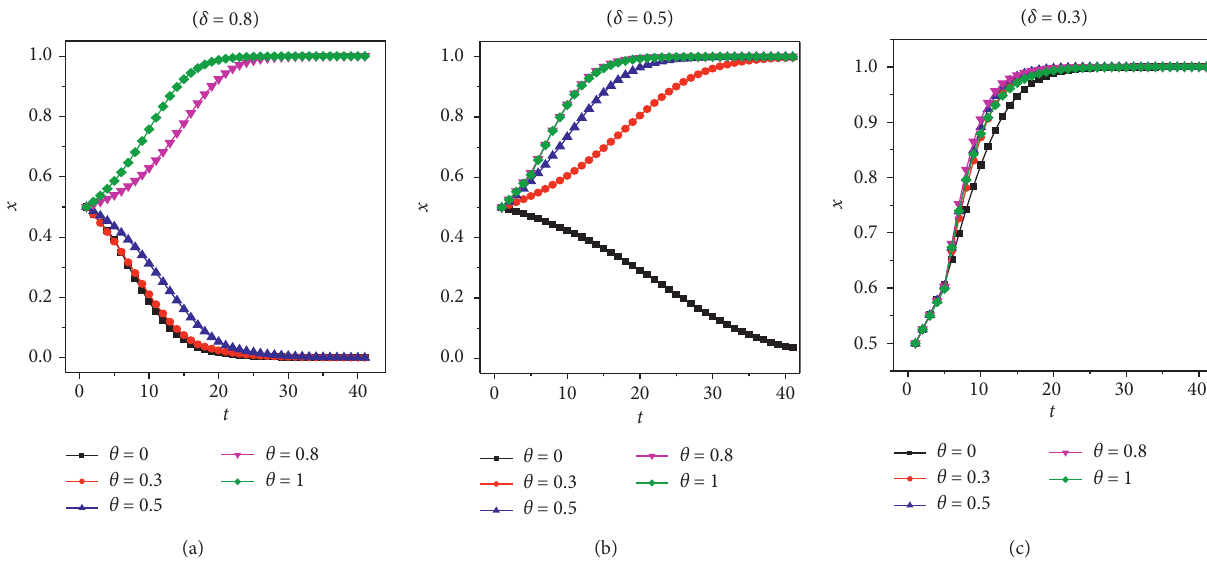
Figure 4: The proportion of innovation-leading firms in the group for different intellectual property protection intensity θ on three levels of the innovation risk δ based on the improved game